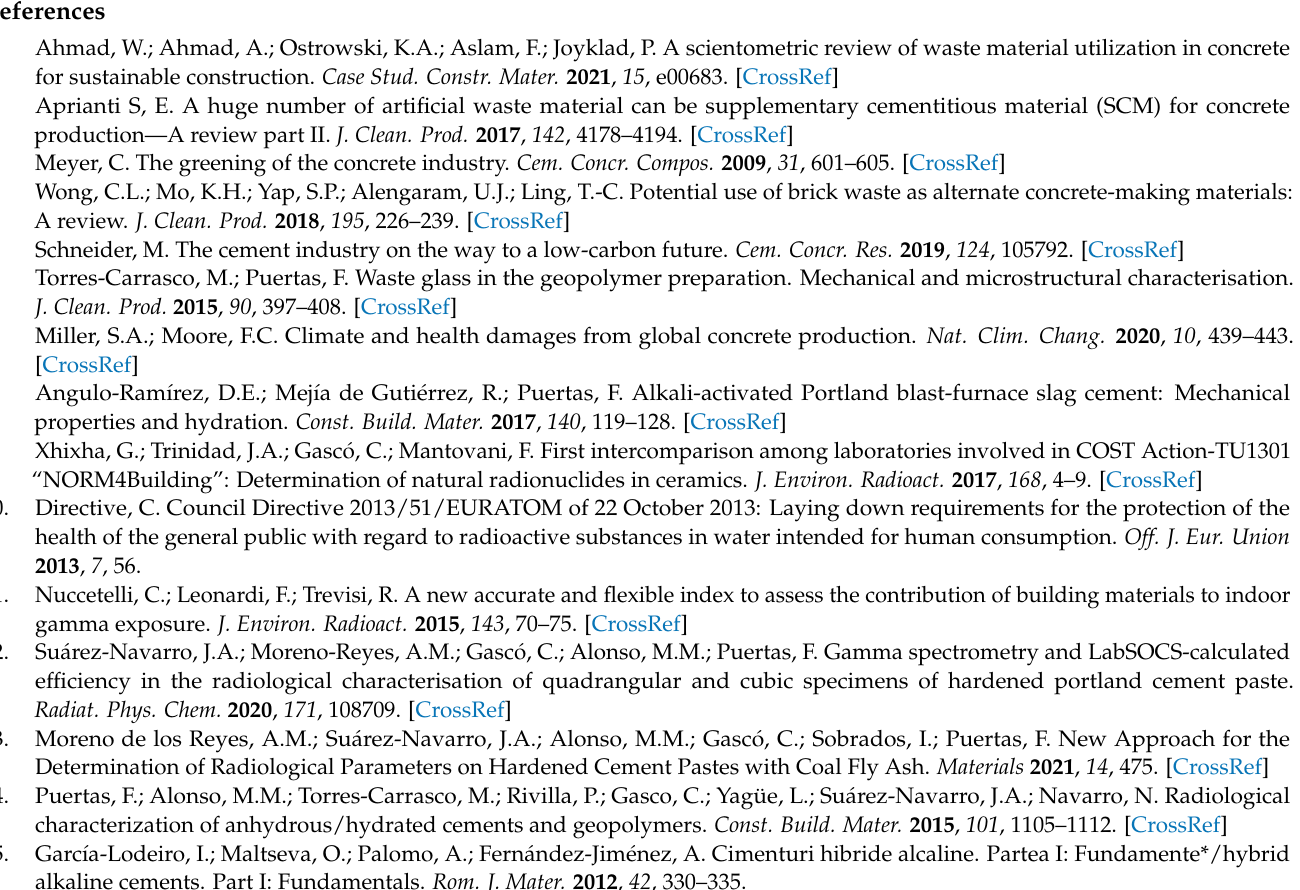
Table S1: Specifications for the high purity germanium detectors used in this